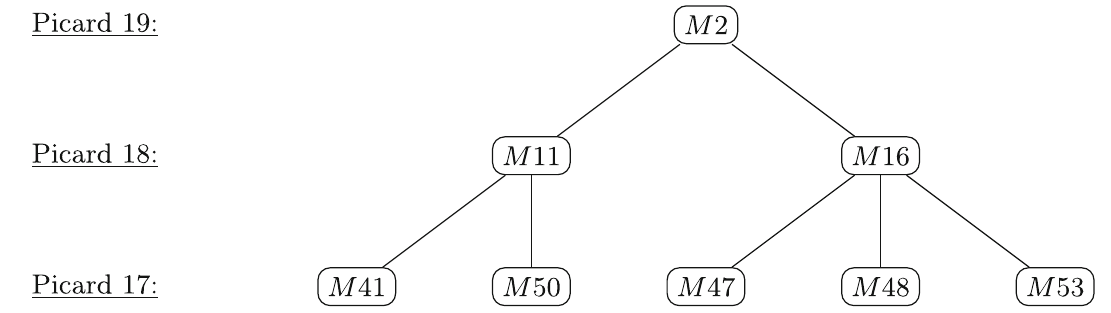
Fig. 4 Polytopes up to 3 complex parameters that are linked to M 2 by removing points in their M lattice (i.e. a monomial in the hypersurface equation)